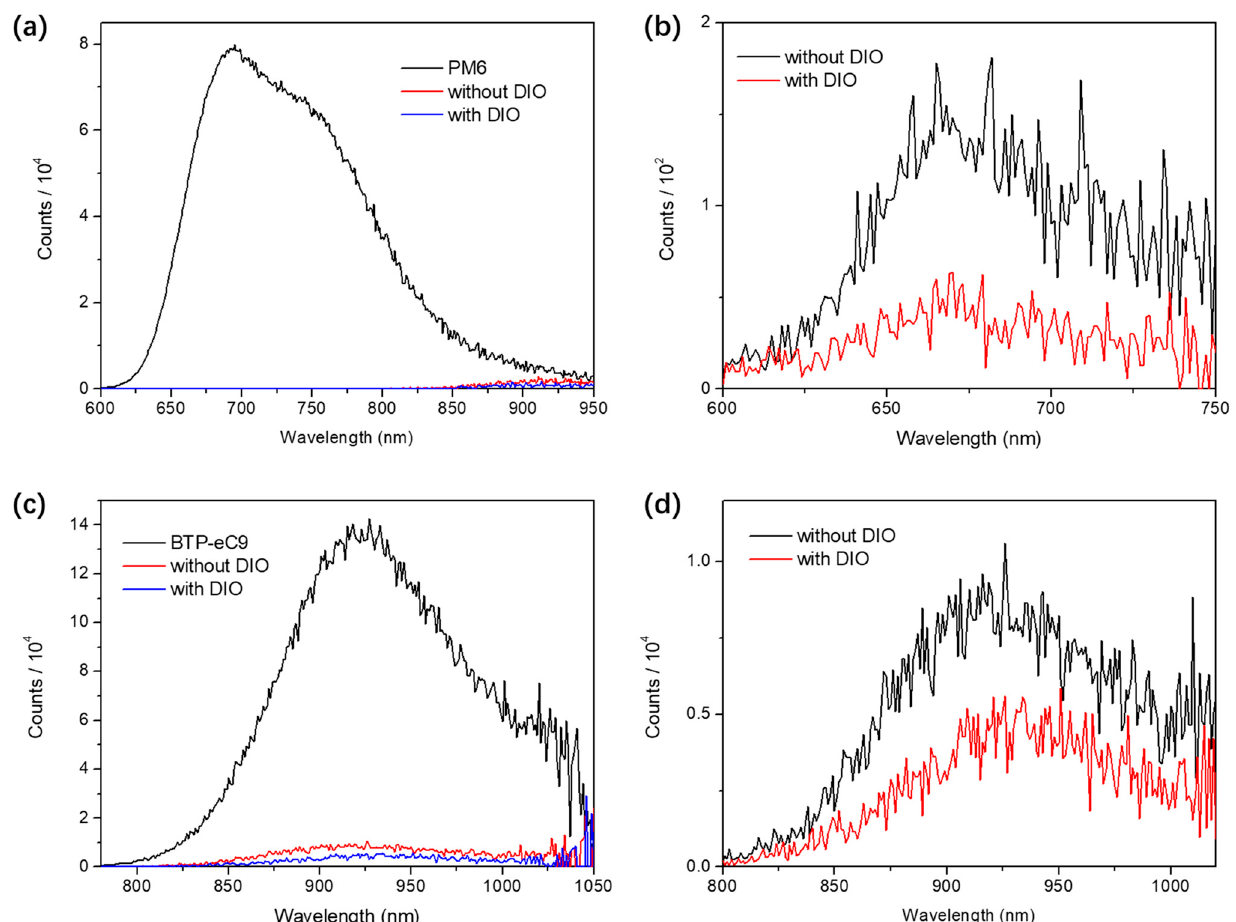
Figure 4. PL spectra of neat PM6, neat BTP − eC9, and ssNP films under excitation of ( a , b ) 560 nm and ( c , d ) 750 nm, respectively.